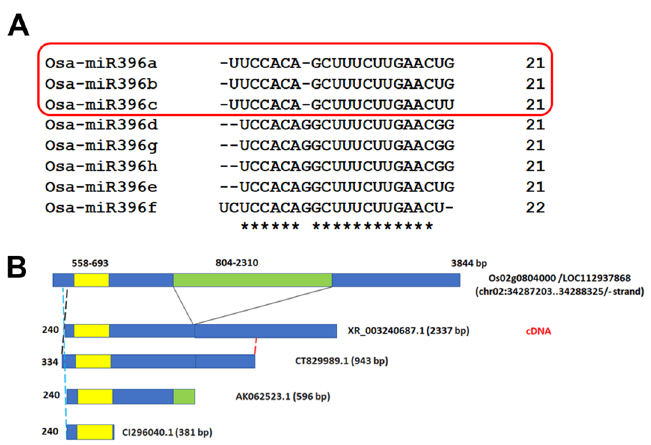
Figure 4. ( A ) Alignment of miR396 mature sequences from O. sativa . Mature miR396a-c sequences group more closely (boxed in red) relative to miR396d-h. ( B ): Pictorial representation of the miR396c locus in O. sativa ( Os02g0804000 ; negative stand; chromosomal coordinates indicated) with corresponding non-coding RNA (ncRNA; XR_003240687.1) and cDNA/EST sequences reported in the NCBI database. Exonic segments are indicated in blue, and the intronic region in green. The region marked in yellow in exon 1 corresponds to the pre- miR396c region. Numbers adjacent to dotted green, blue lines (5 ′ end) and red lines (5 ′ end) next to cDNA/ EST sequences indicates corresponding base in the miR396c genomic sequence ( Os02g0804000 ). Of these, cDNA (AK062523.1) shows partial intron